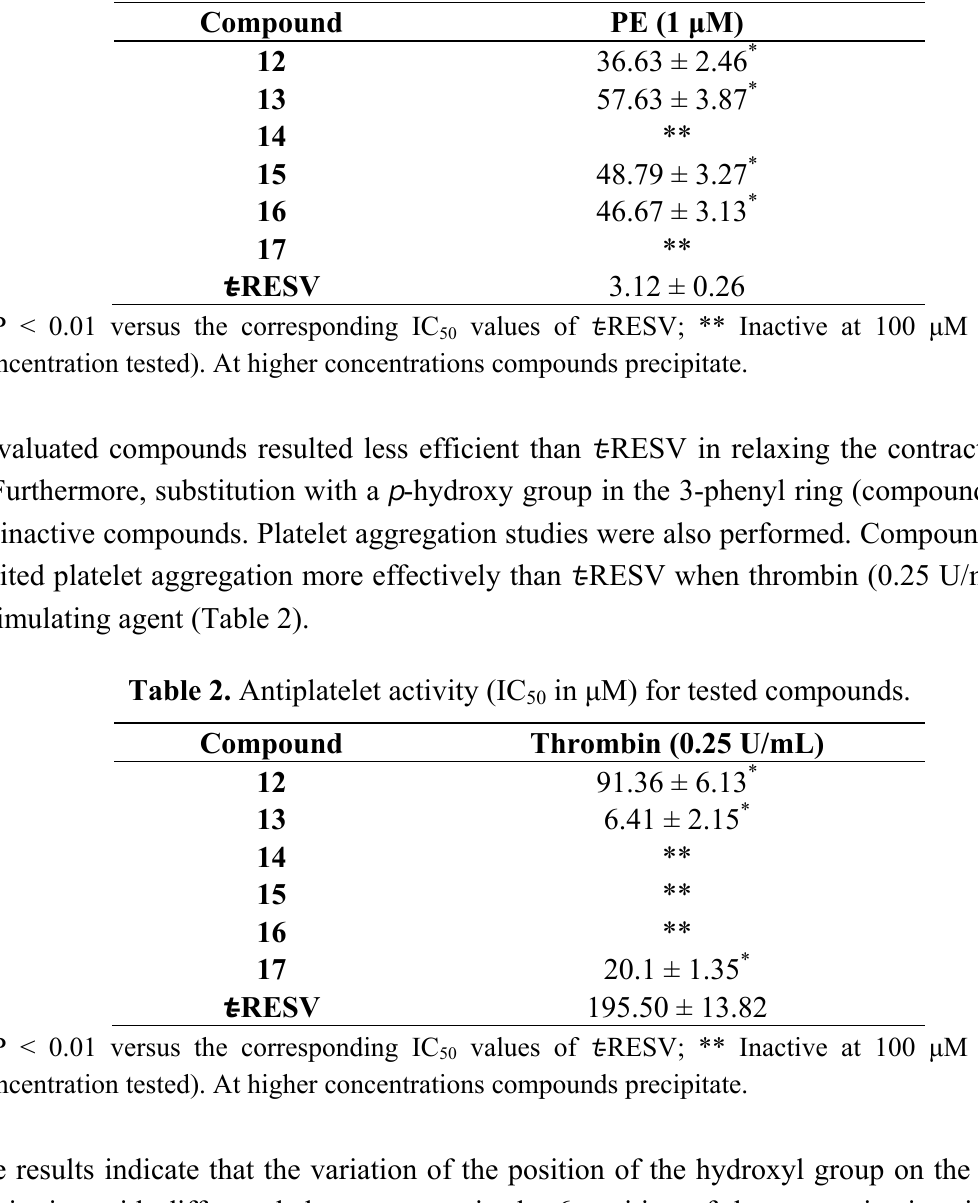
Table 1. Vasorelaxant activity (IC